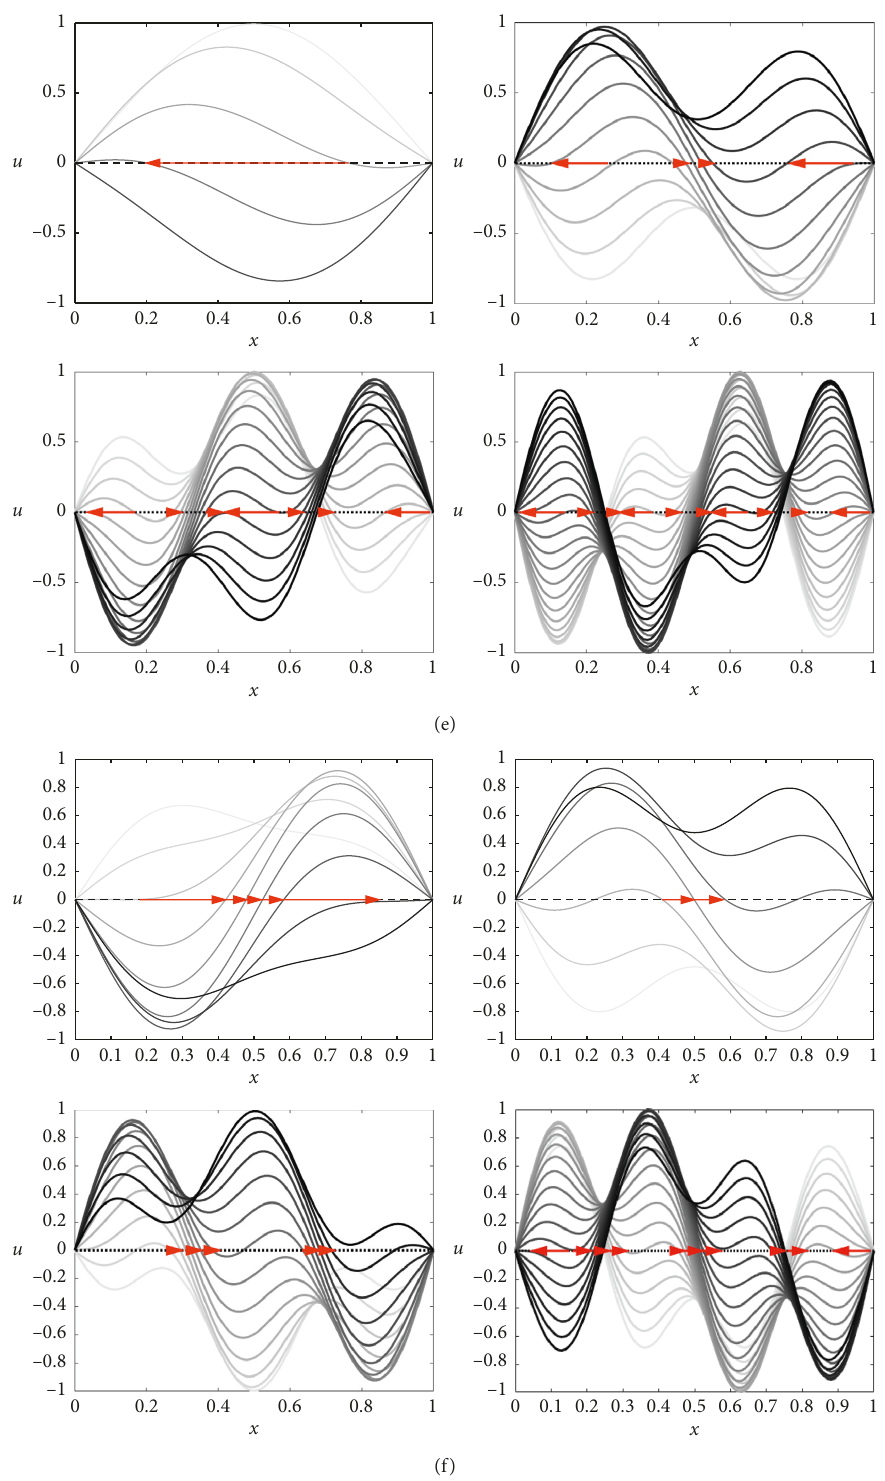
Figure 5: First four-order modes of an axially moving beam with different transport speeds and tensions. Every single curve plotted by the colored levels from shallow to deep denotes the modal motion in different time. The red arrows are the wave direction. Plots of (a), (b), (d), and (e) belong to the case in the stable region I and (c) and (f) belong to the case in the stable region II. (a) μ � 20, v � 5, (b) μ � 20, v � 10, (c) μ � 20, v � 21.2, (d) μ � 10, v � 5, (e) μ � 10, v � 10, and (f) μ � 10, v �